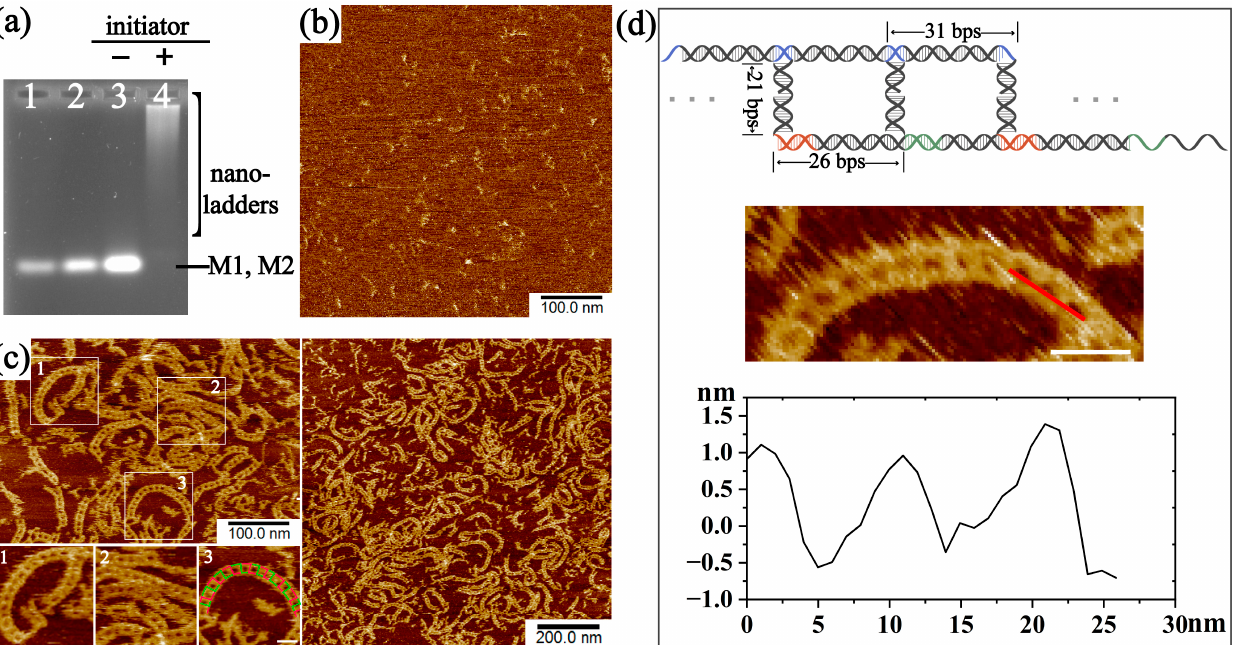
Figure 3. Result analysis of the self ‐ assembly of DNA nanoladders. ( a ) Native agarose gel (1.5%) electrophoresis. The composition of each band is marked on the side of the gel. Lane 1 and lane 2 correspond to M1 and M2, respectively. Lane 3 represents the situation where the mixture solution of M1 and M2 reacts for a period of time without the initiator. Lane 4 represents the situation where